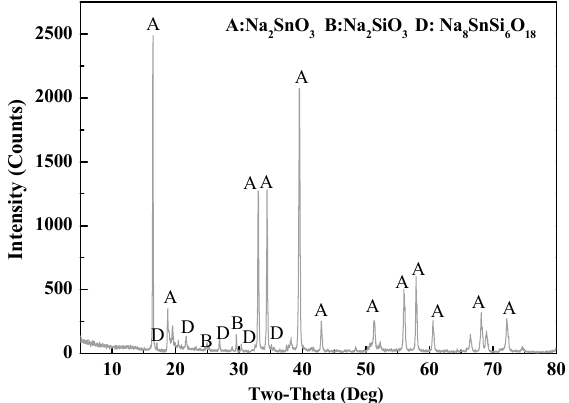
Figure 5. XRD pattern of the roasted samples (Sample 1# in Figure 3).